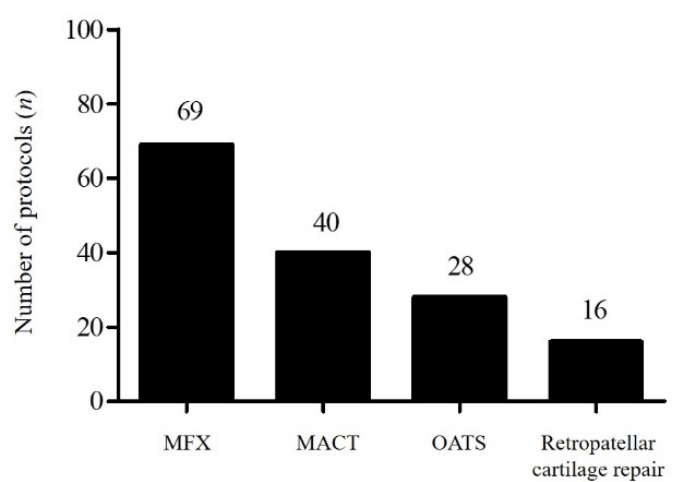
Figure 2. Number of rehabilitation protocols of orthopaedic institutions concerning cartilage repair techniques of the knee joint. MFX: microfracturing; MACT: matrix-assisted cartilage transplantation; OATS: osteochondral autograft transfer system.